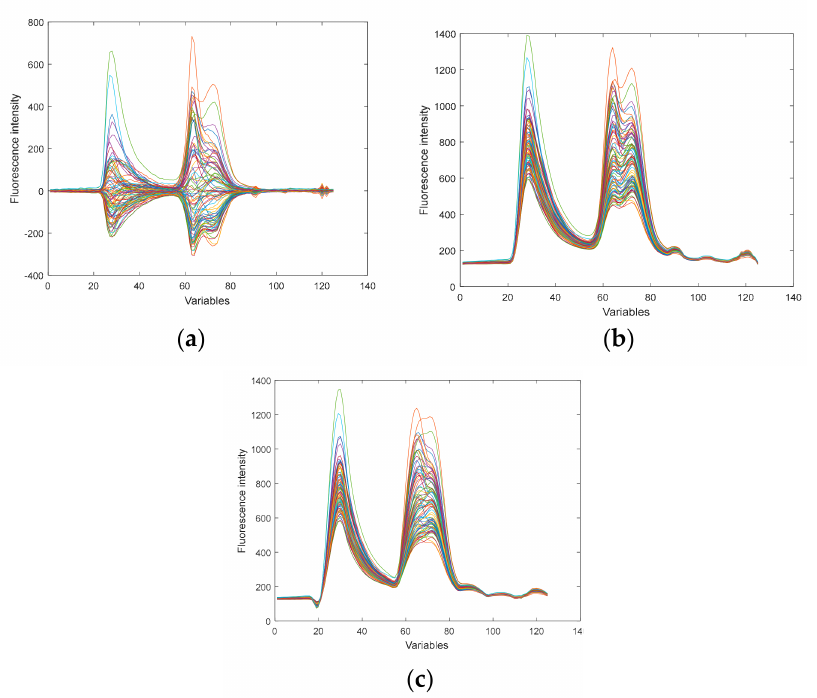
Figure 6. The spectral images preprocessed by three algorithms: ( a ) the spectral images preprocessed by de-trending; ( b ) the spectral images preprocessed by moving average; ( c ) the spectral images preprocessed by Savitzky–Golay smoothing.